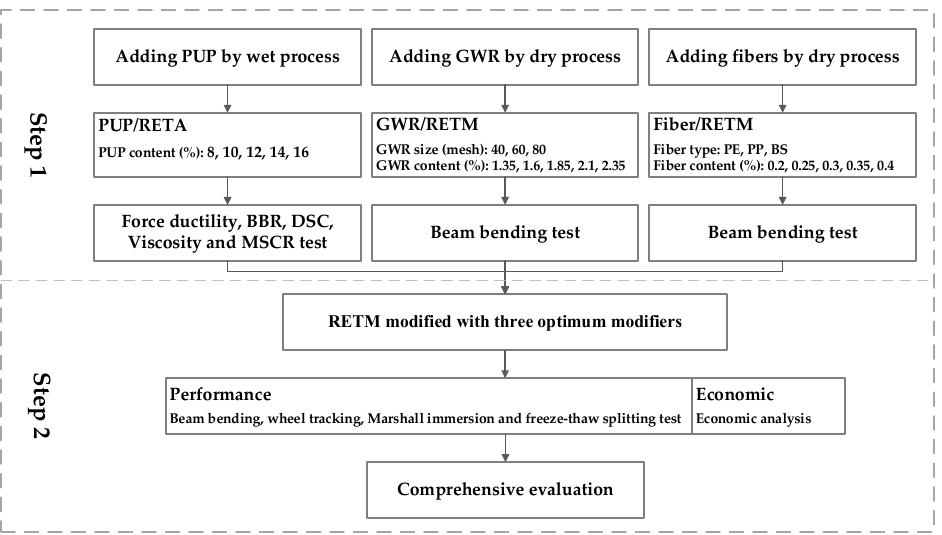
Figure 1. The flow chart of the experiment.